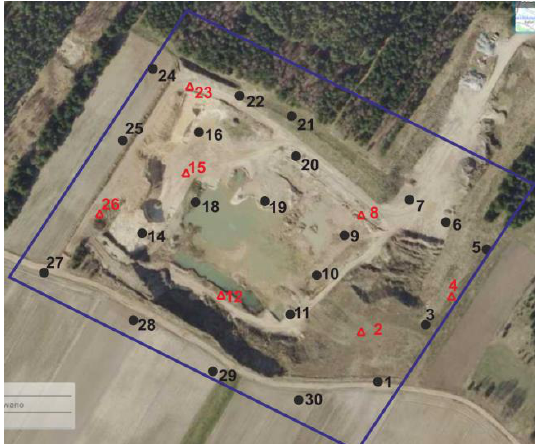
Figure 8. The arrangement of photogrammetric network points on the study site.